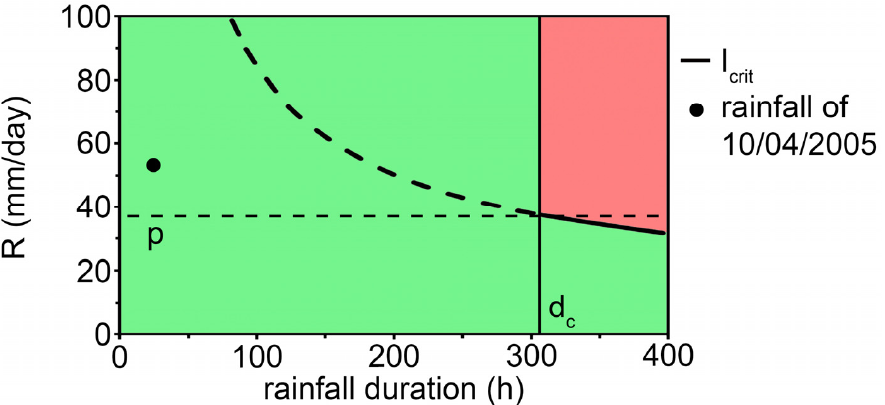
Figure 11. Comparison between the rainfall event recorded on 10 April 2005 and the critical curve calculated at the depth of 1.40 m.